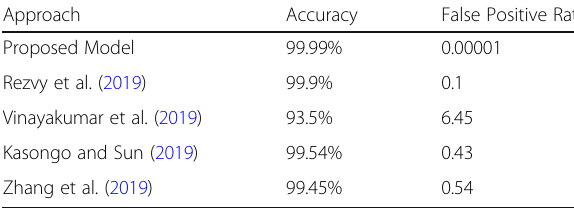
Table 7 Overall Performance of the Model for lr = 0.1 Epochs Table 8 Performance Comparison of the Proposed Model with Extant State-of-the-Art Approaches